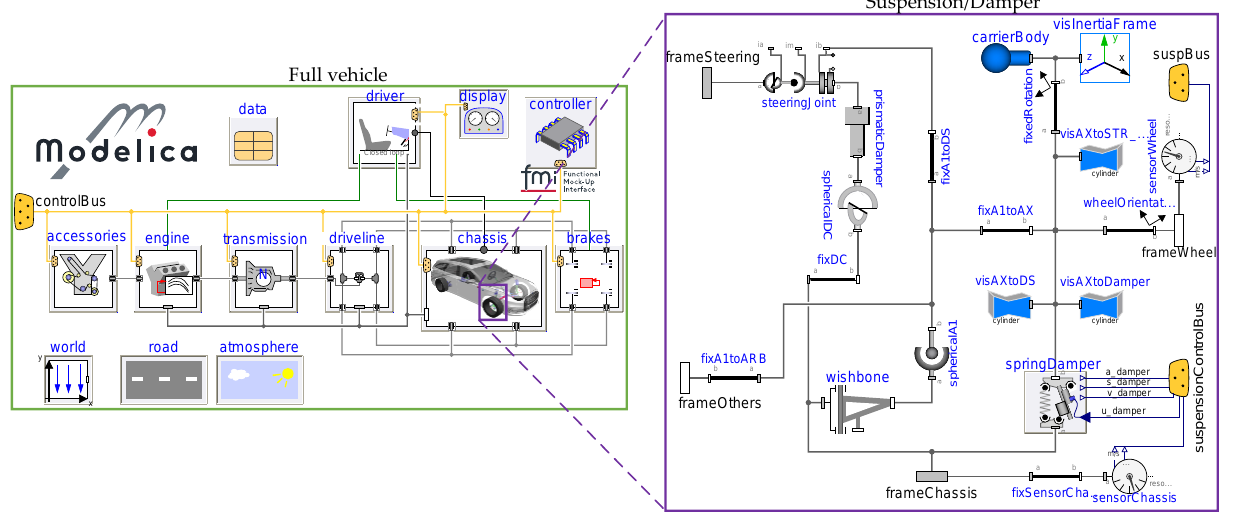
Figure 12. Overview of the full vehicle model in Modelica ( left ) and a sub-model of the front wheel McPherson suspension ( right